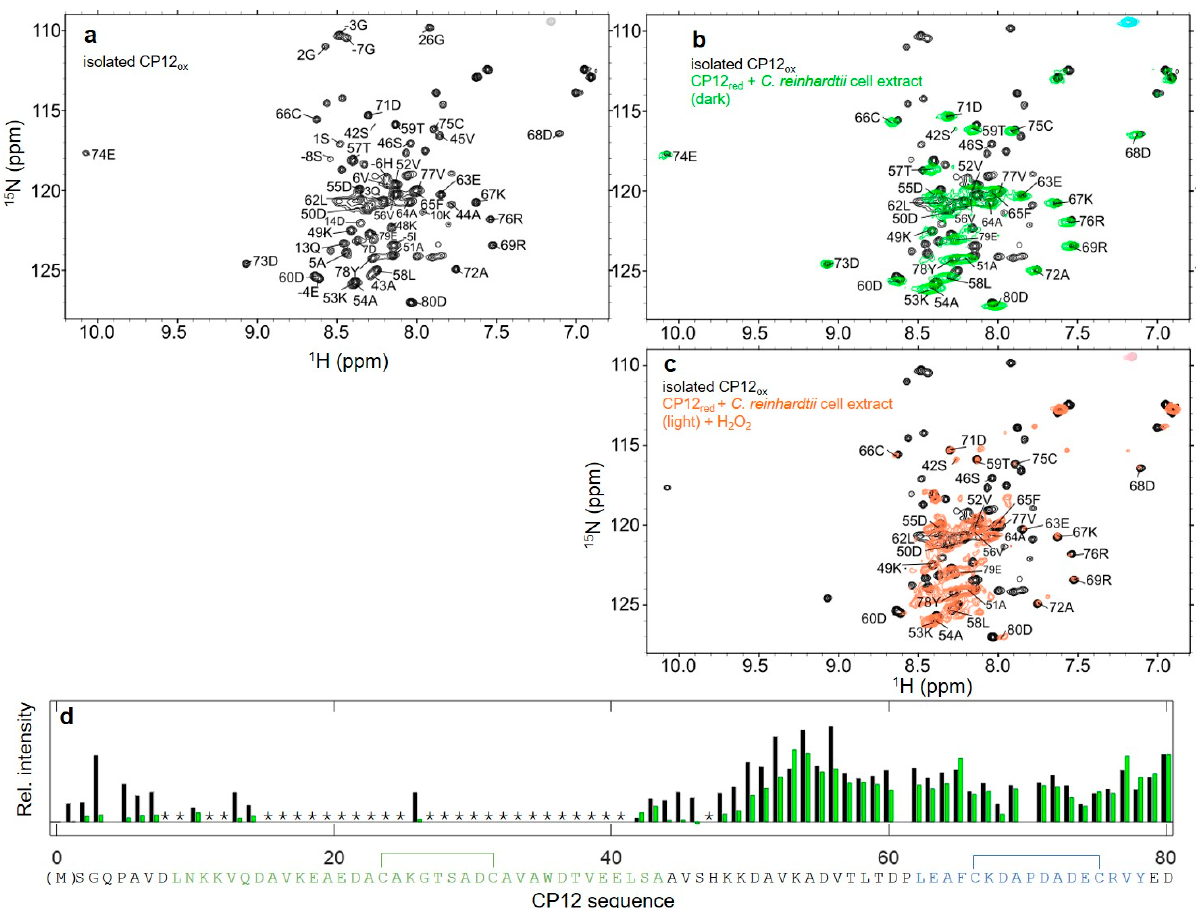
Figure 5. CP12 ox in isolation and in the presence of C. reinhardtii cell extract. ( a ) 1 H- 15 N HSQC spectrum of isolated CP12 ox . ( b ) Overlay of the 1 H- 15 N HSQC spectra of isolated CP12 ox (black) and that of CP12 in the presence of C. reinhardtii cell extract (green, molecular crowding corresponding to 19 mg mL − 1 of protein). The data is recorded in the presence of 20 mM DTT ox , and 0.1 mM DCMU. The assignments of the resonances that are observed in the presence of cell extract are indicated. ( c ) 1 H- 15 N HSQC of CP12 in the presence of C. reinhardtii cell extract collected in the light (molecular crowding corresponding to 15 mg mL − 1 of protein) and 20 mM H 2 O 2 as a strong oxidizing agent. ( d ) Signal intensities for all residues in the 1 H- 15 N HSQC spectrum of isolated CP12 ox (black), and in the 1 H- 15 N HSQC spectrum of CP12 ox in presence of C. reinhardtii cell extract (green). The signal intensities are normalized against the mean of all intensities. The stars indicate residues for which the resonances are broadened beyond detection in isolated CP12 ox [31], and the disulfide bridges are indicated above the sequence. The CP12 sequence is indicated below the graph with same color coding as in Figure 2.